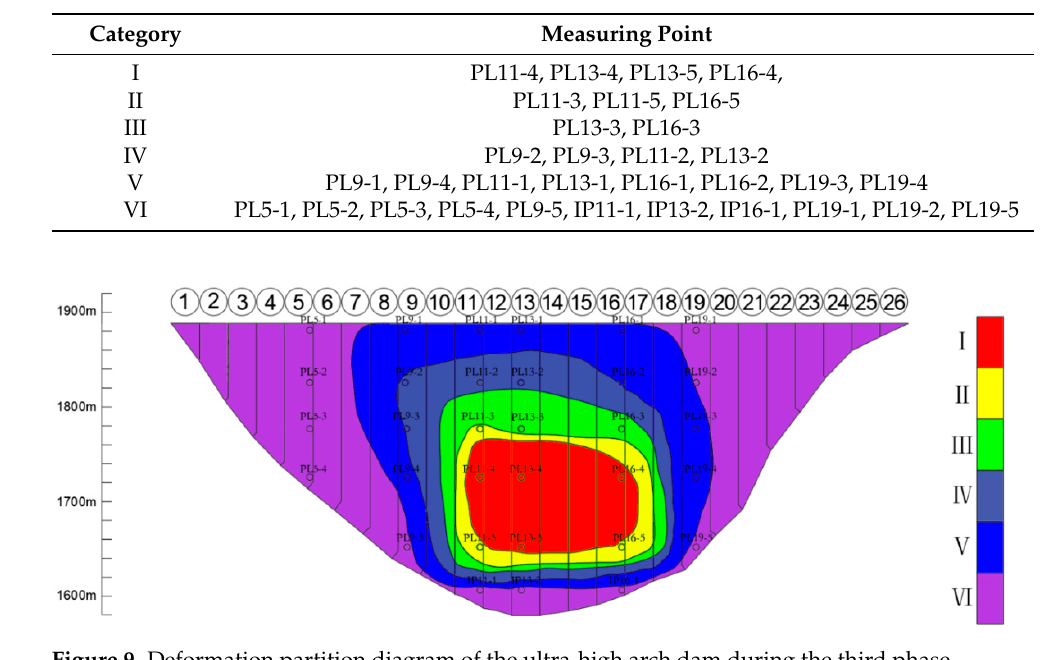
Figure 9. Deformation partition diagram of the ultra-high arch dam during the third